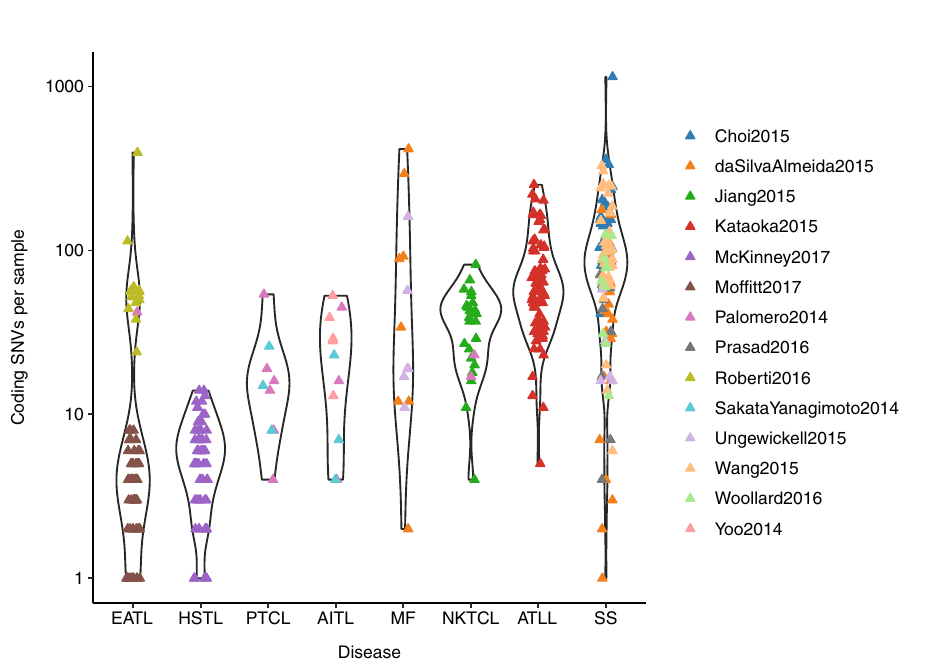
Figure 2. Number of coding SNVs per sample across disease subtypes. Data were collated for those studies where full mutation lists were published and for subtypes where sequencing had been performed on at least 10